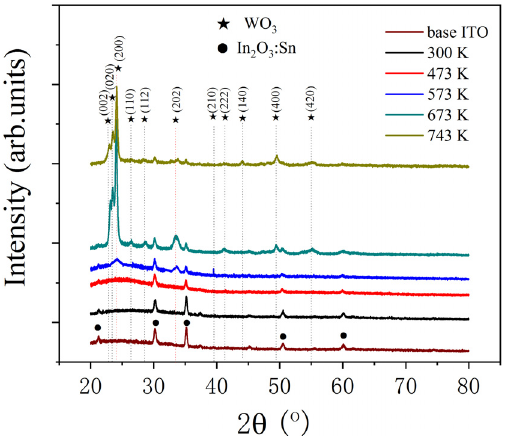
Figure 1. X-ray di ff raction (XRD) patterns of the WO 3 thin films deposited at di ff erent Figure 1. X-ray diffraction (XRD) patterns of the WO 3 thin films deposited at different substrate substrate temperature.